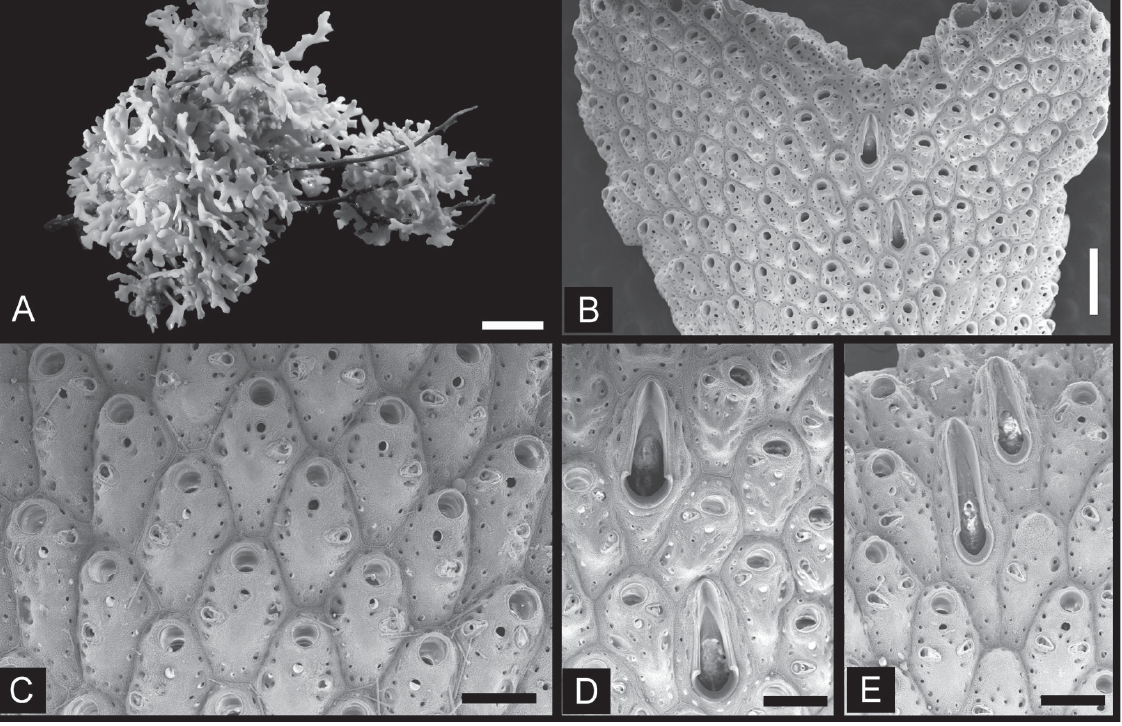
Fig. 2. Adeonella cf. lichenoides (Lamarck, 1816). A . Large, robust branching colony in showa emperor Collection (NsMT-Bryr299, sagami sea). B . Distal end of branch, showing vicarious avicularia associated with a branch bifurcation (NsMT-Bryr297, sagami sea). C . Autozooids